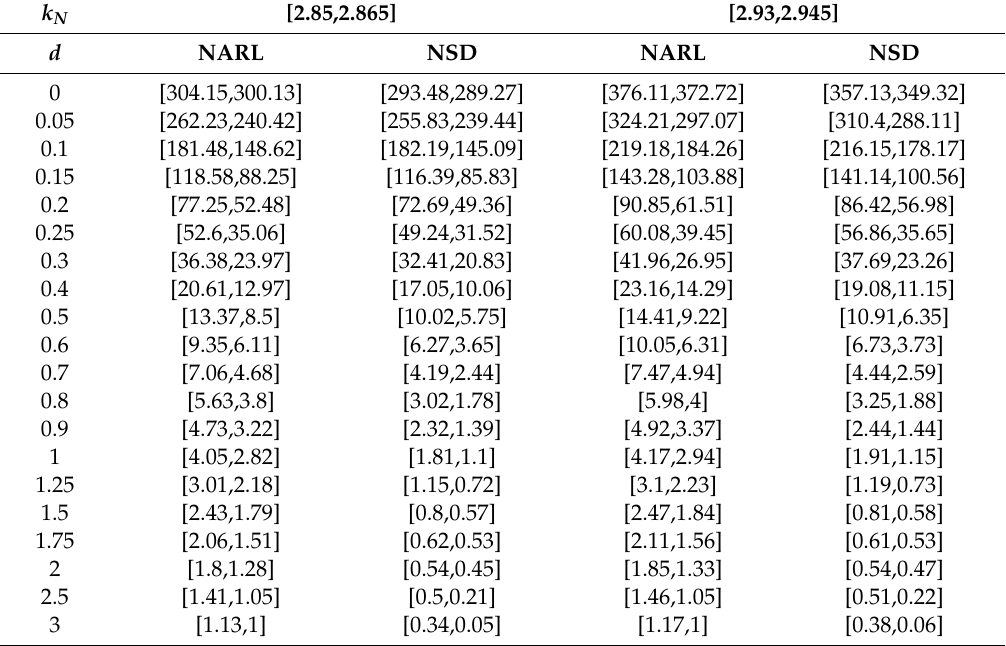
Table 3. The values NARL and NSD when n N (cid:15) [ 3,5 ] and λ N (cid:15) [ 0.28,0.32 ]